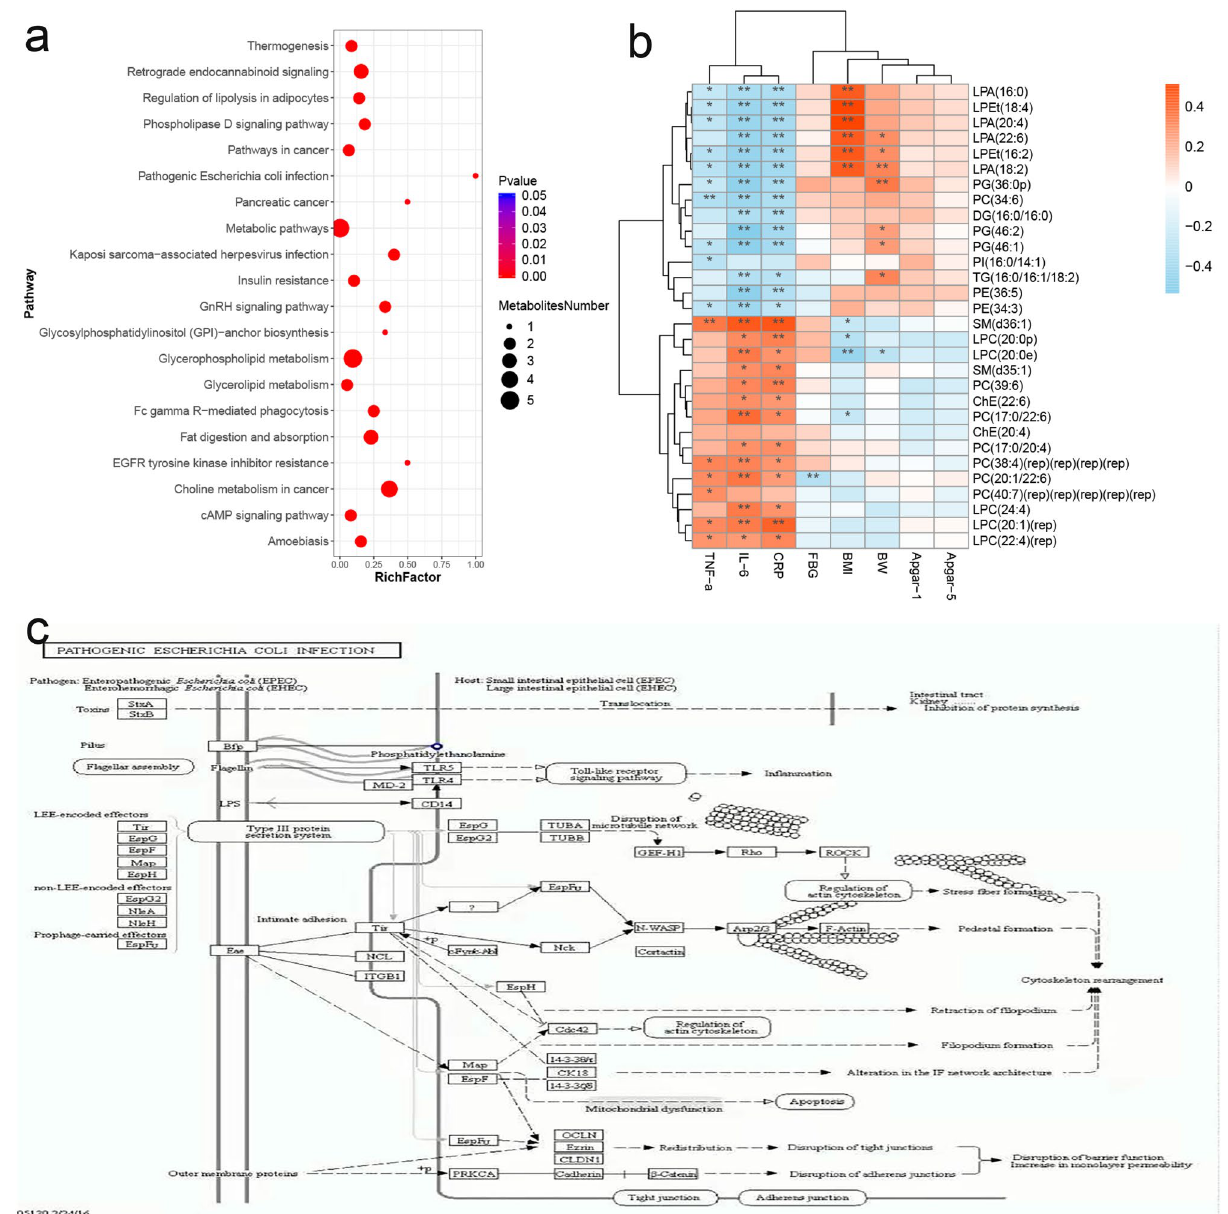
Figure 3. Pathways analyses and correlation between potential biomarkers and clinical data. ( a ) Scatter plot of KEGG enrichment. ( b ) Correlation between potential biomarkers and clinical data. ( c ) Pathogenic Escherichia coli infection response pathway. (Note: BMI BMI at enrollment; BW birth weight; Apgar-1: Apgar scores at 1 min; Apgar-5: Apgar scores at 5 min. *, p < 0.05; **, p <